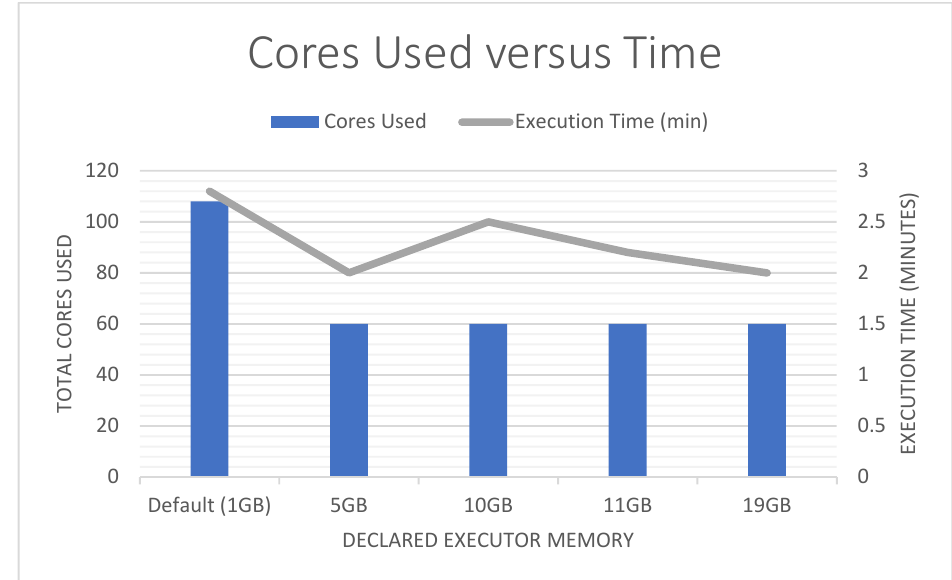
Figure 5. Cores versus Execution Time and Total Cores Used.